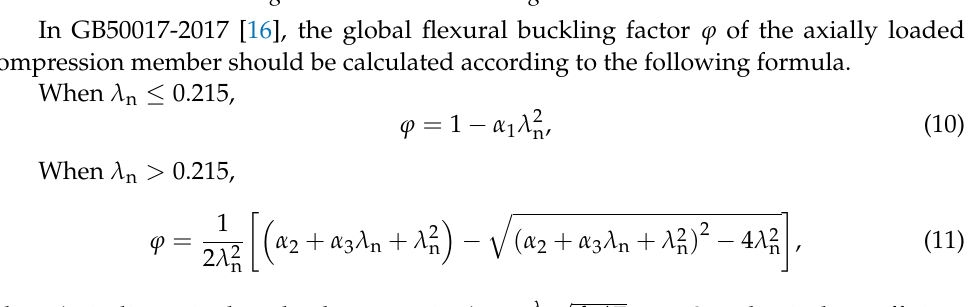
Table 5. Coefficient α 1, α 2, and α 3 according to GB 50017-2017 [16].